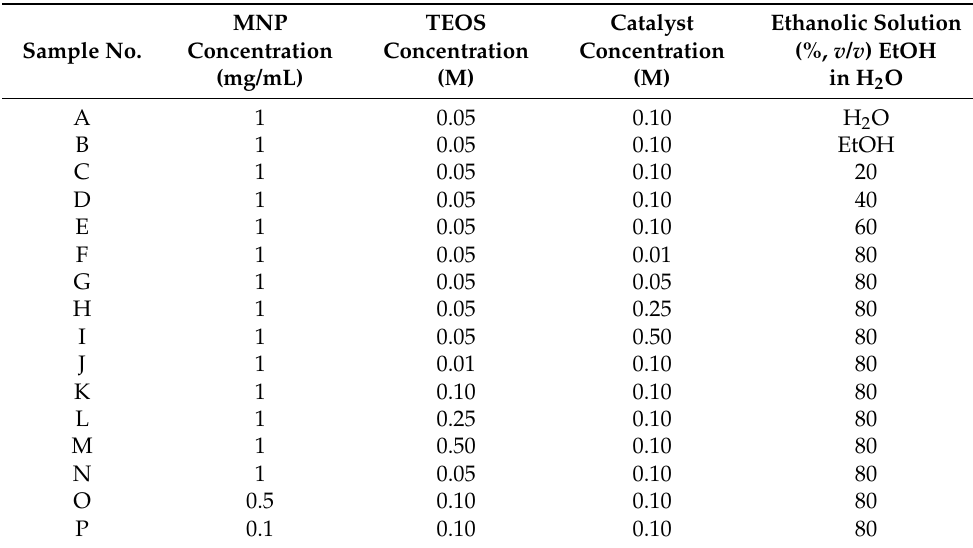
Table 1. Conditions for synthesis of